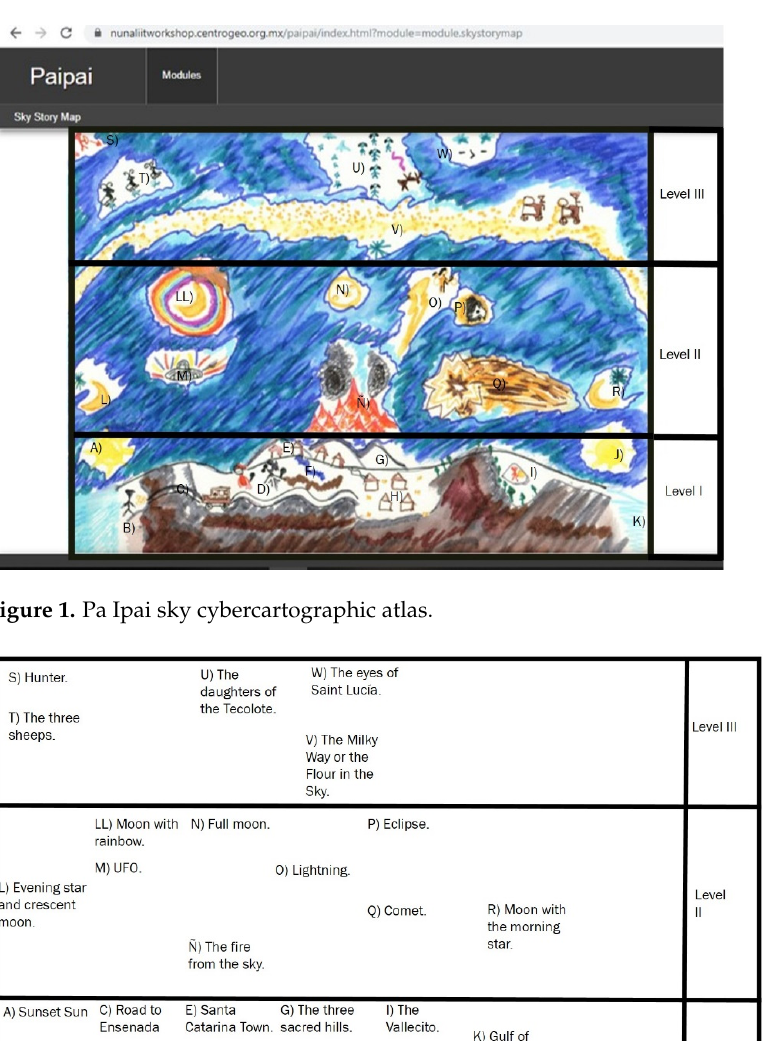
Figure 2. Pa Ipai sky cybercartographic atlas.